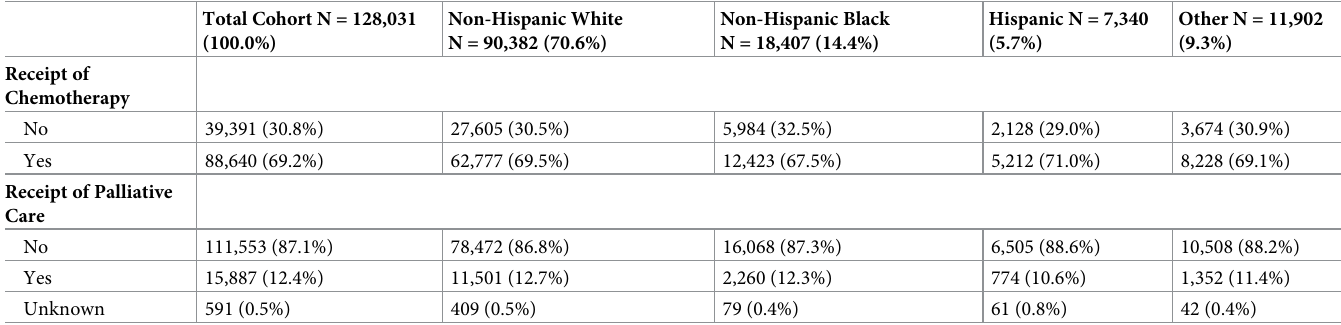
Table 2. Receipt of chemotherapy and receipt of palliative care by